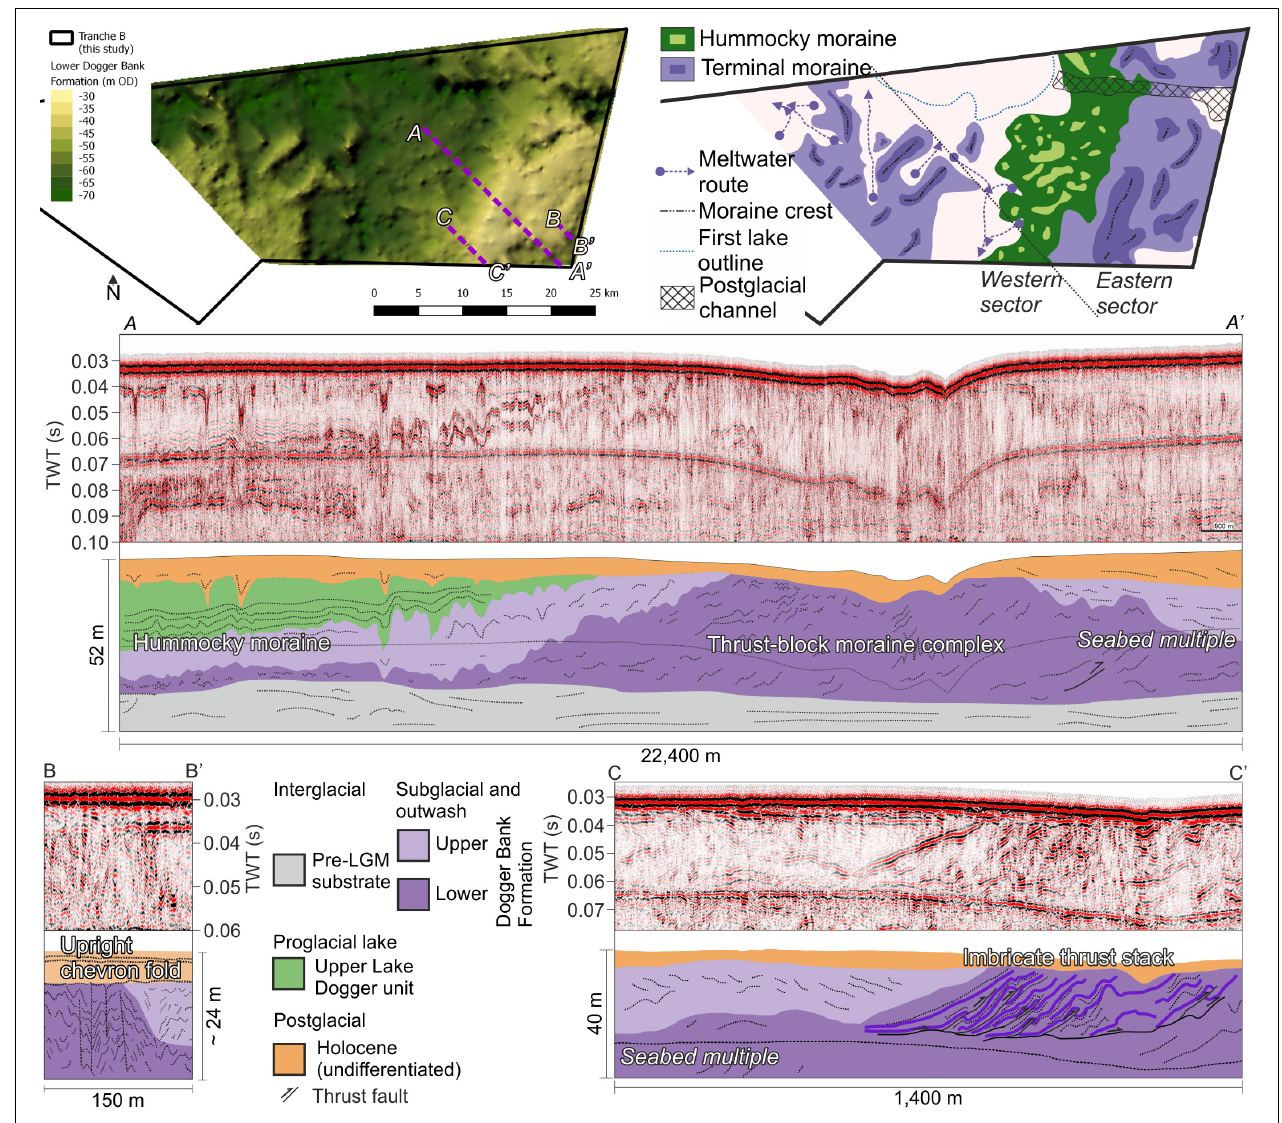
FIGURE 4 | Map of the top Lower sub-unit of the Dogger Bank Formation, revealing the large terminal thrust-block moraine complex, an area of hummocky moraine, and smaller moraines to the west. Seismic section (A,A’) , through the thrust-block moraine complex, shows the internal deformation, with thrust faults and asymmetric serrate reflectors implying a southeast vergence direction. Seismic section (B,B’) shows symmetric serrate reflectors that show chevron folding in a different section of the thrust-block moraine complex. Seismic section (C,C’) shows extensive imbrication and thrust faulting of